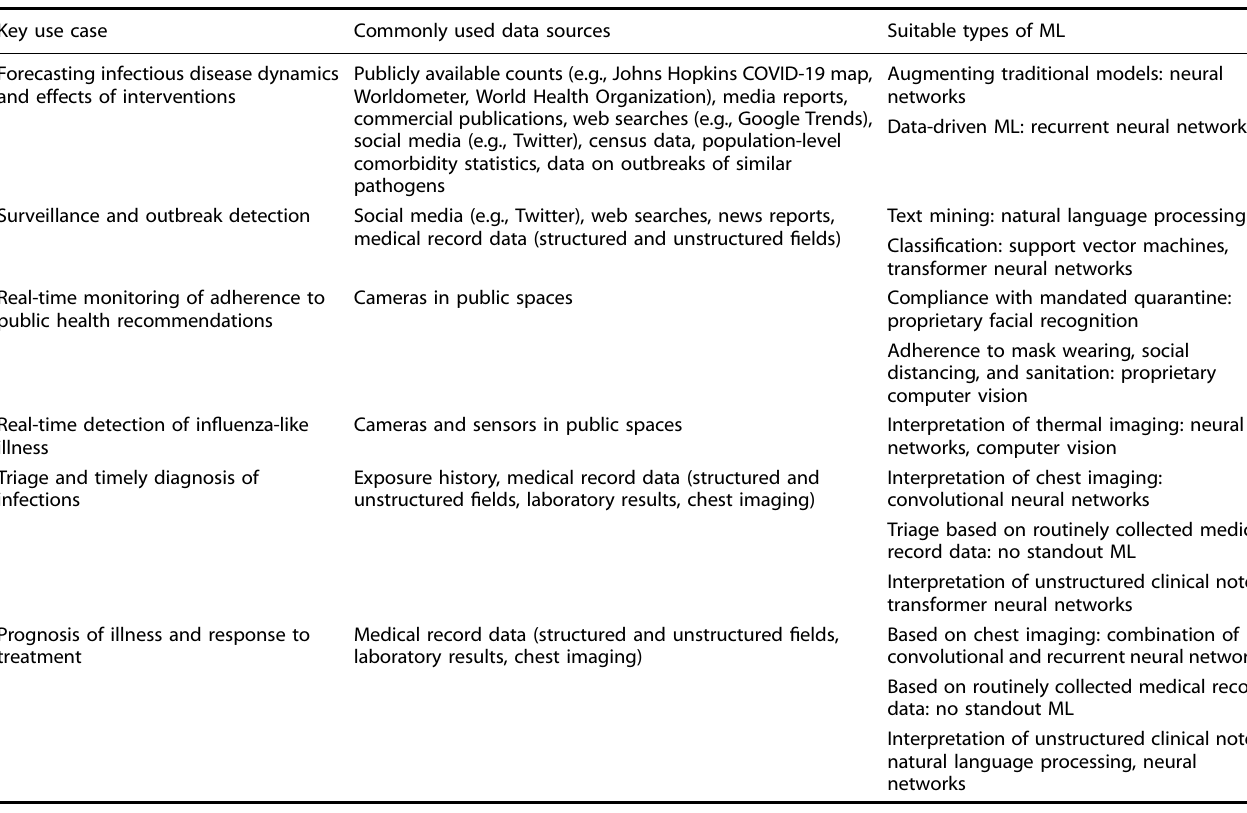
Table 6. Commonly used data sources and types of machine learning suitable for each use case based on studies from the in-depth review about past pandemics, SARS, and COVID-19. Key use